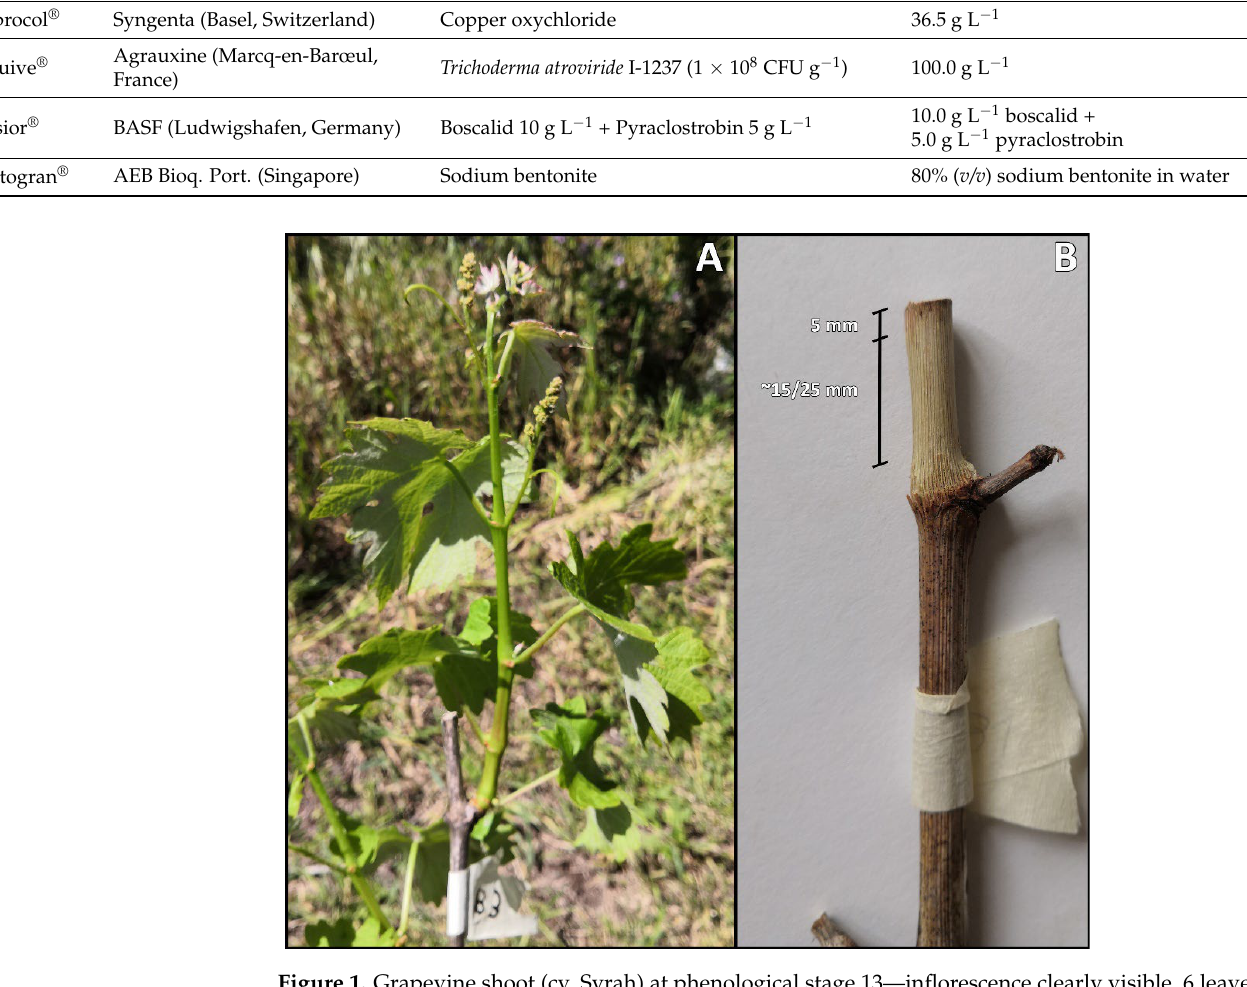
Table 1. Pruning wound protection products applied to three-day-old pruning wounds.